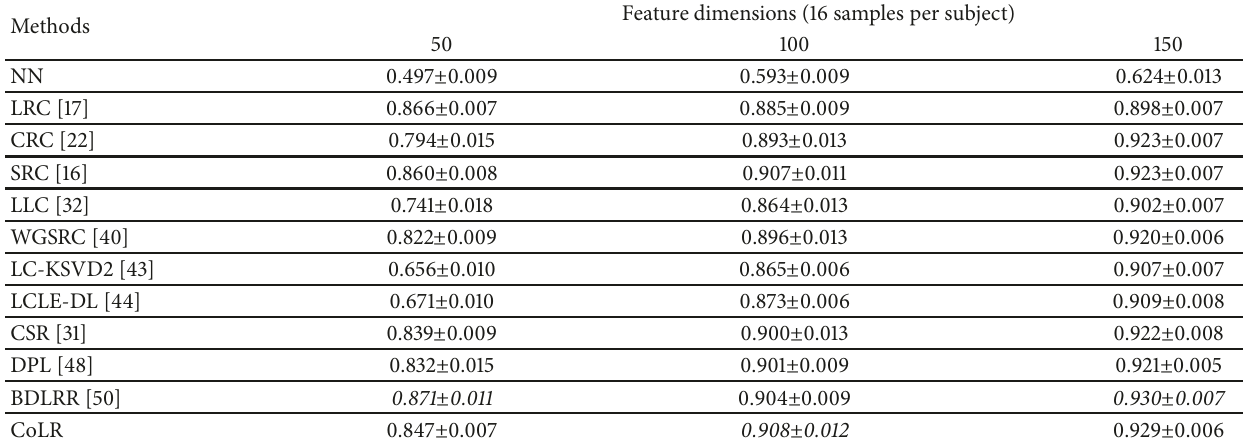
Table 6: Recognition rates on the Extended Yale Bdataset under different feature